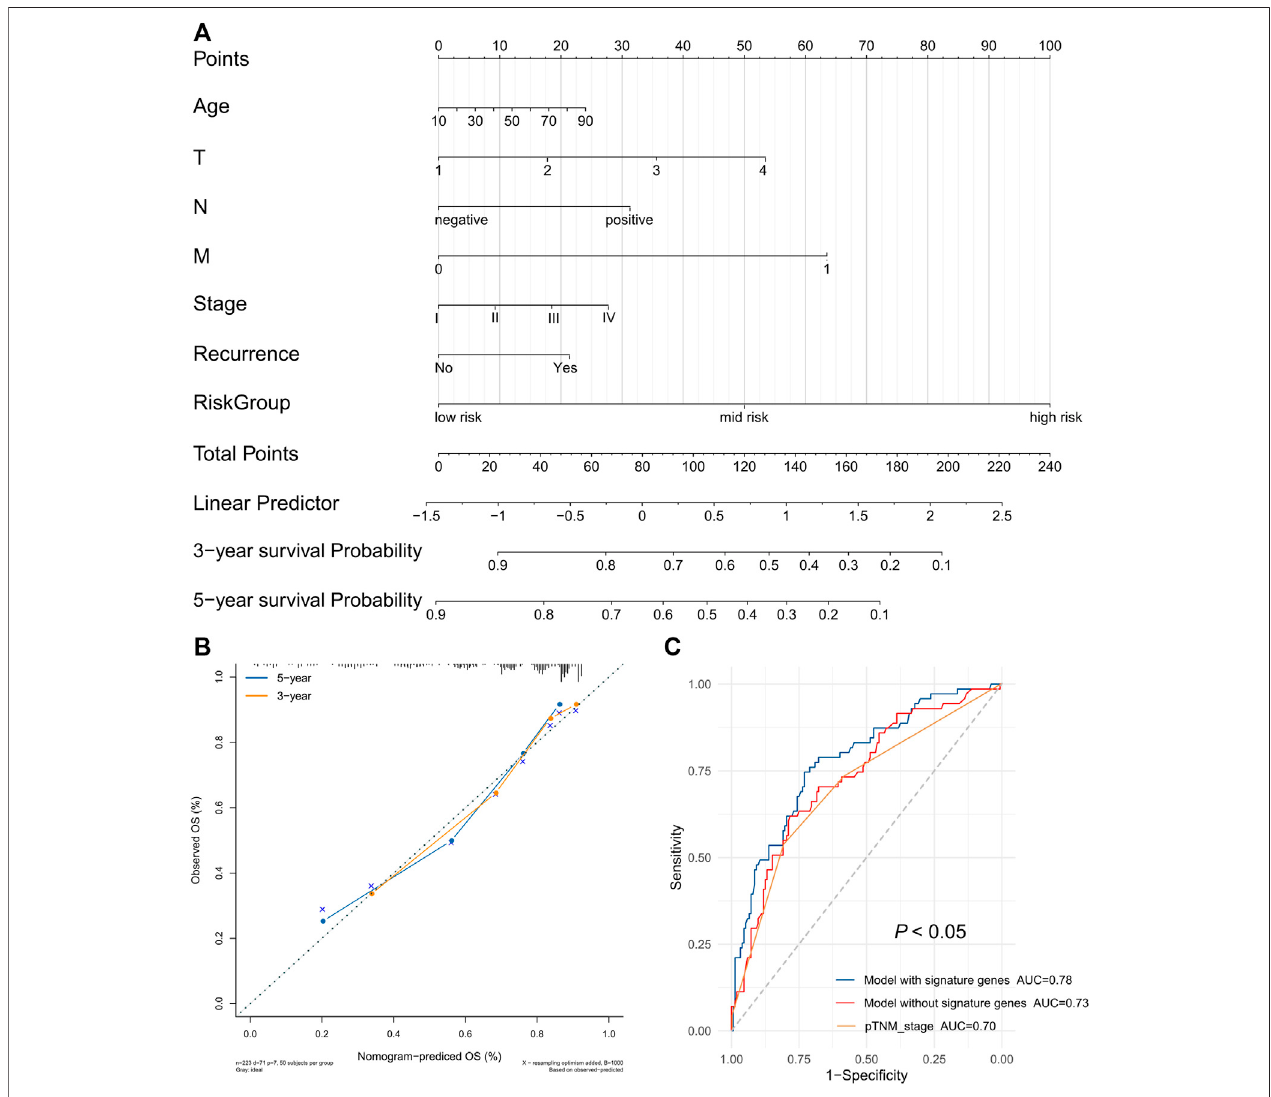
FIGURE 9 | The prognostic nomogram with the risk score in HCC. (A) A nomogram for predicting 3- and 5-year survival possibilities of HCC. (B) The calibration curve of 3-year and 5-year survival. (C) Time-dependent receiver operating characteristic (ROC) curves for gene signature and TNM stage.